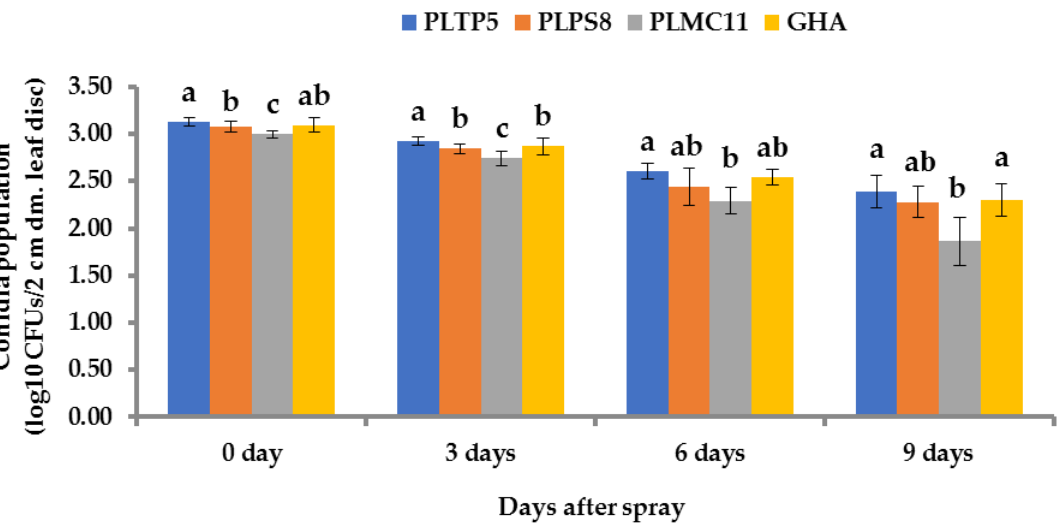
Figure 8. Population of conidia (log 10 CFUs/2 cm diameter leaf disc) recovered at different times from sugarcane leaves sprayed with conidia formulation (1 × 10 8 conidia mL −1 ) of the isolates. Different letters (a–c) in columns indicate significant differences ( p ≤ 0.05) among the isolates. Columns represent the mean ± SD ( n = 3). SD = standard deviation.